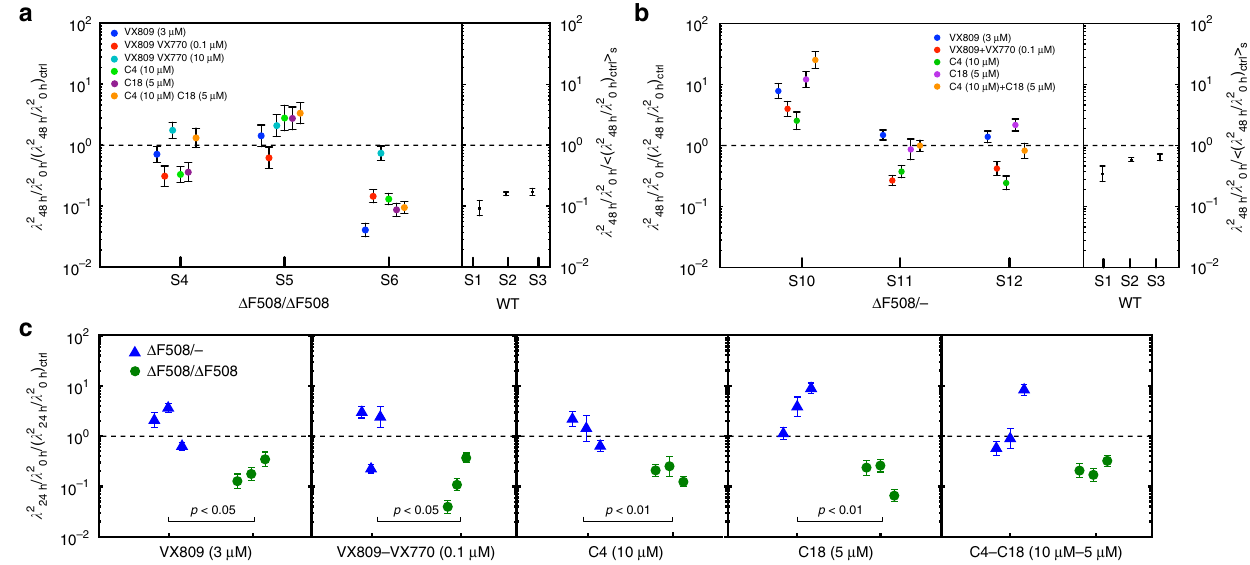
Fig. 5 Ciliary beating coordination length scale upon CFTR-modulating drugs is patient dependent. The response to 48 h treatment with CFTR-modulating drugs is shown in a and b for samples from subjects of Δ F508/ Δ F508 and Δ F508/ − genotype, respectively. Samples from subjects with Δ F508/ Δ F508 genotype responded better as a group to the same panel of drugs after 24 h of treatment. This is shown in c where we plot the response to the same CFTR- modulating compound for subjects of both genotypes. Samples from Δ F508/ Δ F508 subjects had their coordination length scale moved signi fi cantly further towards healthy phenotype values than samples from Δ F508/ − subjects. p -value was calculated with unpaired, one-tailed Student ’ s t -test on log 10 ( λ 2 ). Signi fi cance was not found only in the difference in response to the combination of C4 and C18. Error bars show the uncertainty on the response measurements. Each data point in CF data pertains to one compound-treated sample, normalised by the control sample from the same subject. Healthy data were instead normalised by the average change in coordination length scale in samples of the relevant CF genotype. All data are from nasal